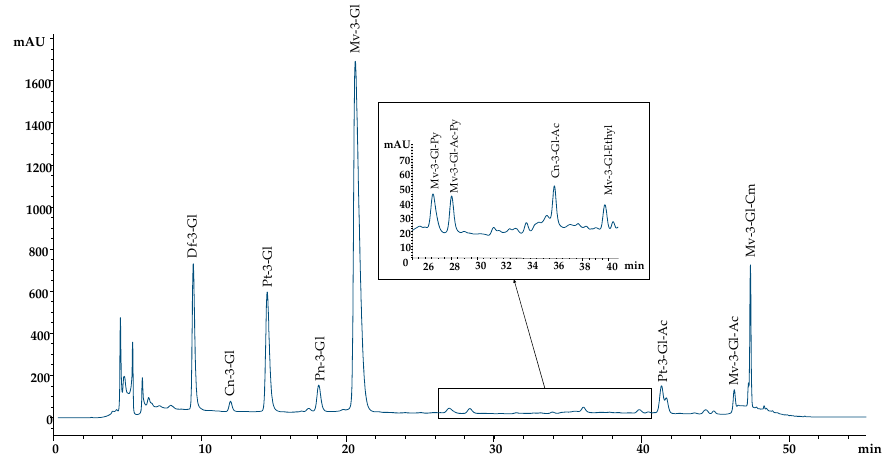
Figure 1. Chromatogram with anthocyanin peaks identification.